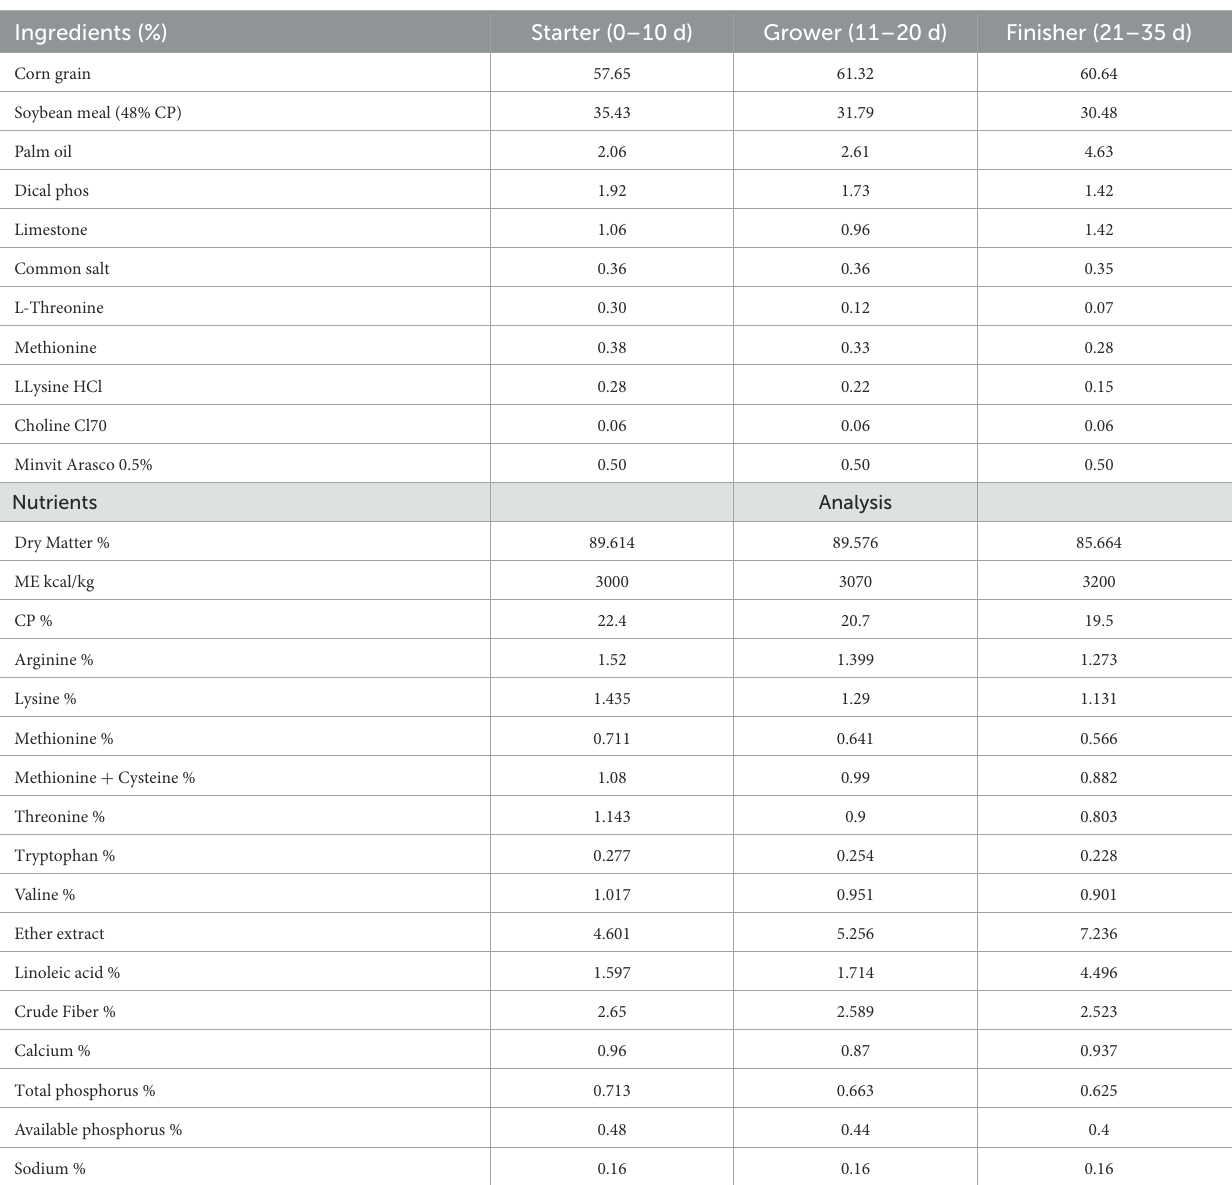
TABLE 1 Composition of experimental diets and nutrients